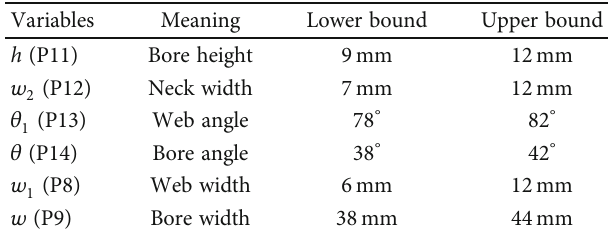
Table 1: De fi nition of design variables.